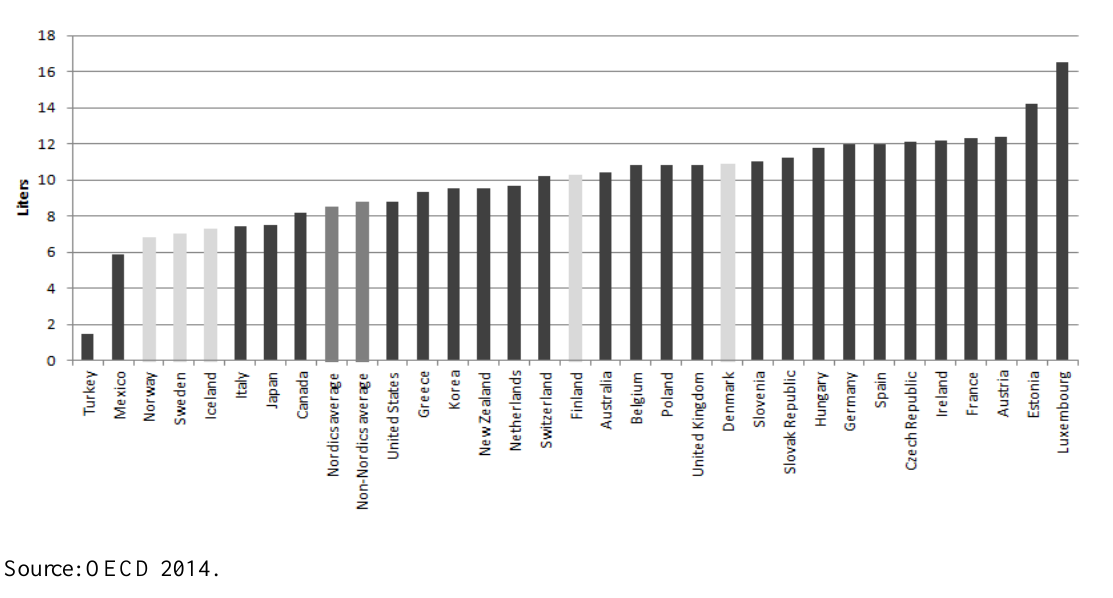
Figure 1: Consumption of pure alcohol per capita of individuals aged fifteen or older,